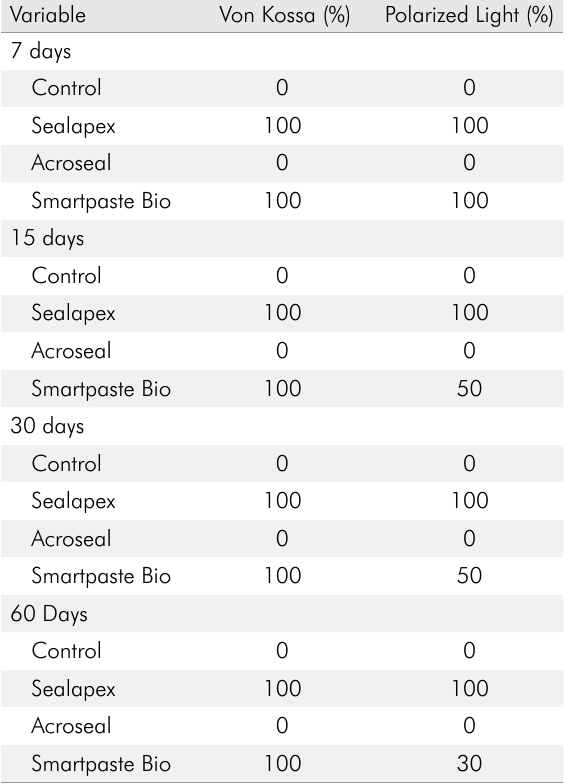
Table 2. Percentage of samples in each group categorized according to Von Kossa positive to mineralization and presence of birefrigents crystals under polarized